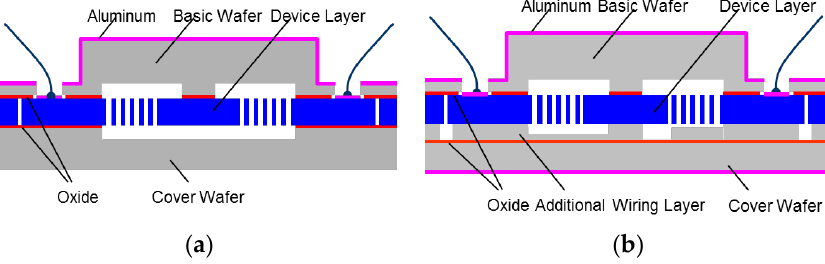
Figure 3. Gyroscope Chip Technology: ( a ) Classical 3-layer SOI; ( b ) Improved Bridge Technology.